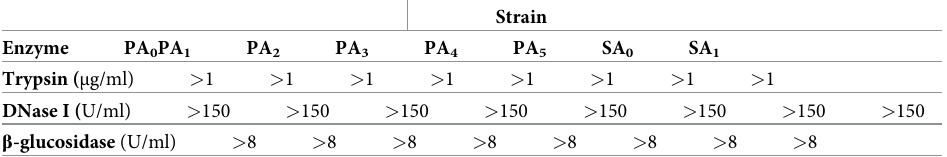
Table 3. MIC values of the enzymes against each strain.